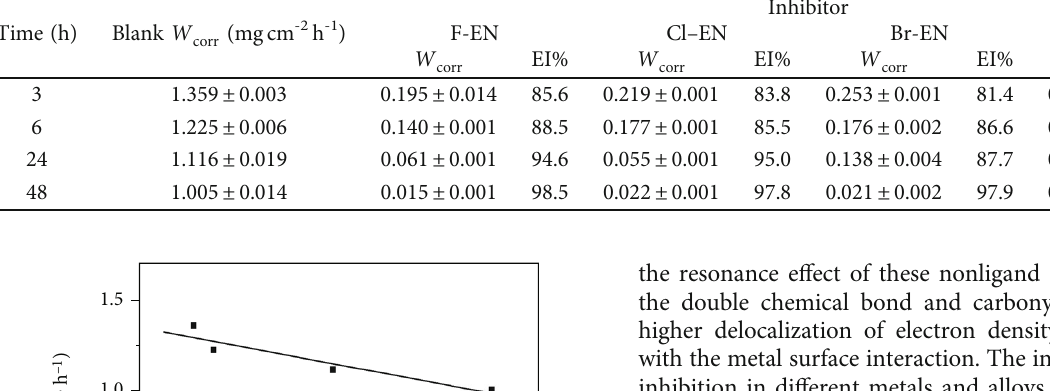
Table 5: Results of weight loss assays of carbon steel AIS 1020 including corrosion rates ( W inhibitors, and corrosion inhibition e ffi ciencies ( EI % ) at 30 ° C with variation in immersion time. Time (h)